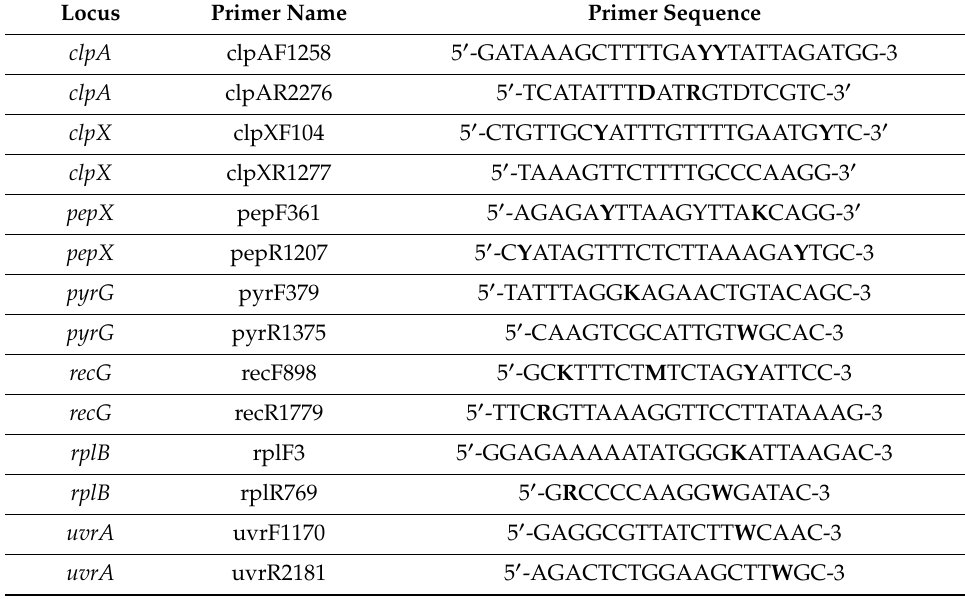
Table 2. Primer * used to amplify MLST housekeeping genes in Borrelia hispanica.